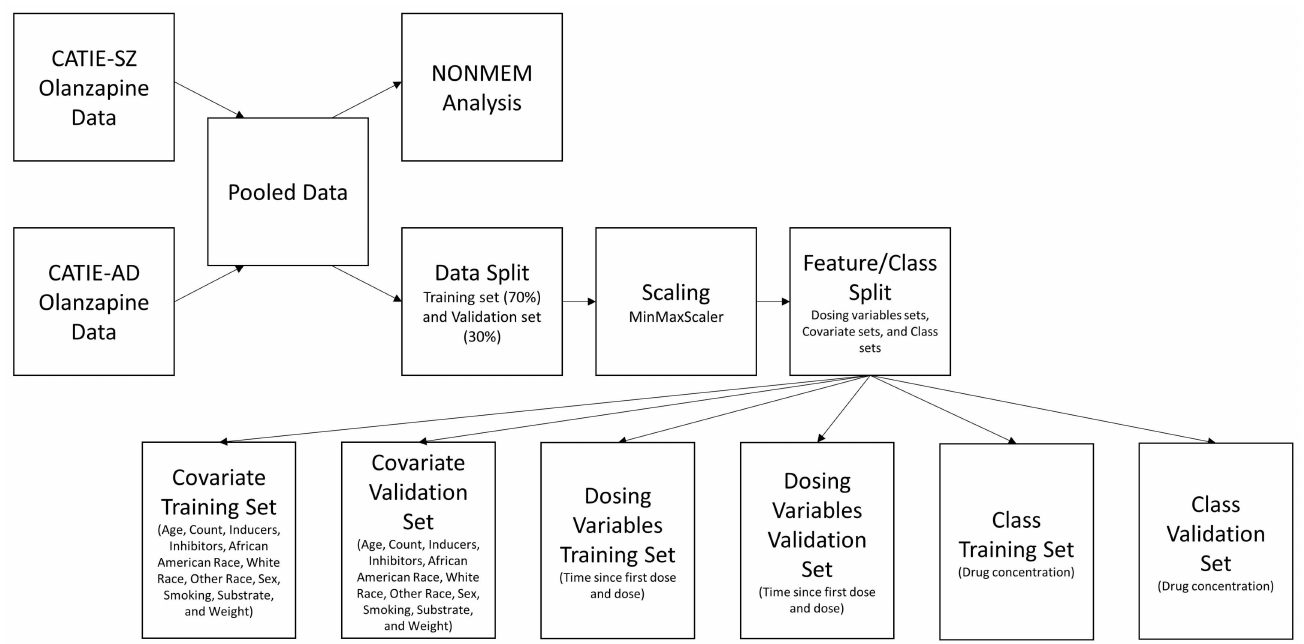
Figure 1. The proposed workflow began with pooling data from the two CATIE trials. The pooled data were used for both the NONMEM analysis and the LSTM-ANN model. The LSTM-ANN model data preprocessing consisted of a data split, followed by scaling, and dividing the data into multiple input features and class training and validation